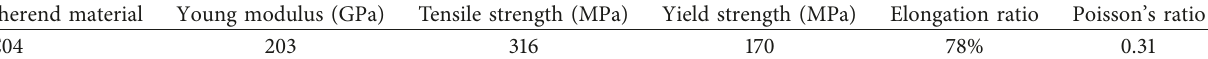
Table 3: Mechanical properties of the DC04